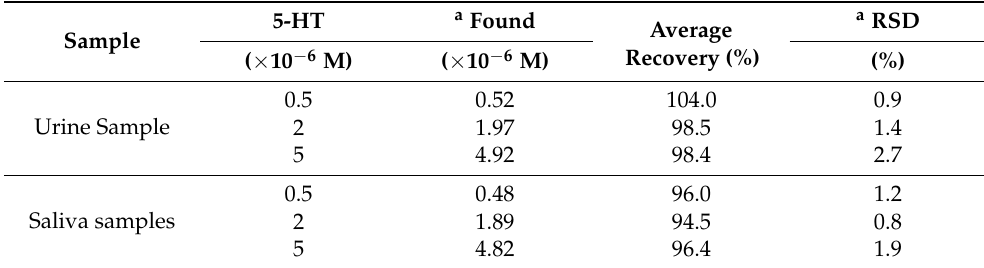
Table 1. Determination of 5-HT in artificial urine and saliva samples using